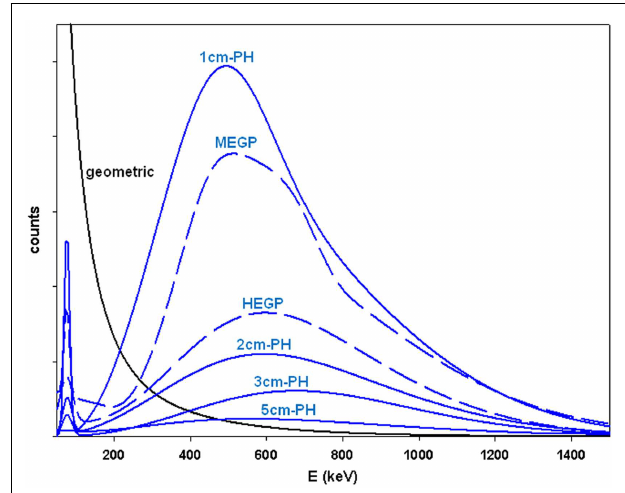
FIGURE 3 | MC simulations of the x-rays counts passing through the collimator material (blue curves) for a 90 Y point source surrounded by 1cm perpex and set 10cm far from the collimator .The curves were rescaled in order to get the same geometric x-rays component (black curve) for all the collimators. Septa thickness is 1.4 and 3.2mm, hole diameter is 3.4 and 4.0mm, hole length is 42 and 40mm, for the MEGP and HEGP collimator, respectively.The length in centimeters is the thickness of the lead front plate of the pinhole (PH) collimator.The aperture diameter is 8mm and the focal length is